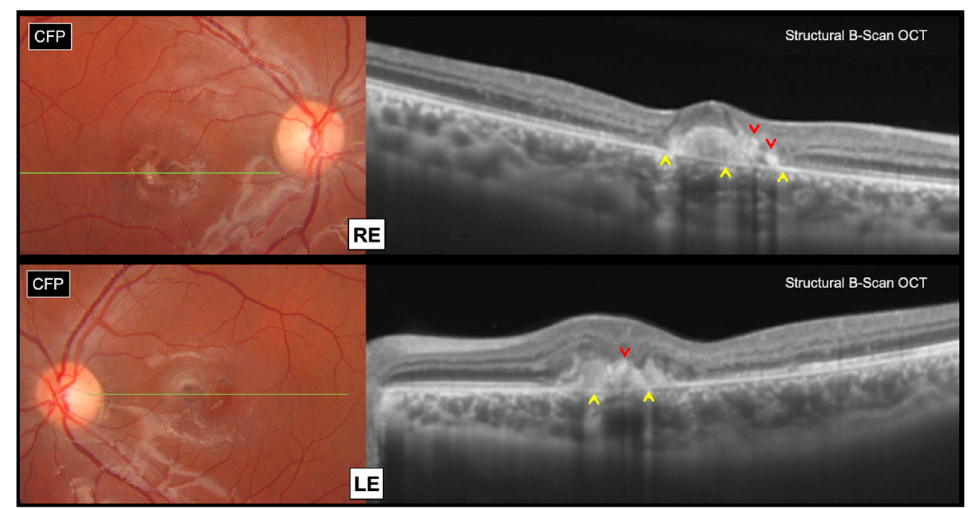
Figure 2. Swept source structural B-Scan OCT of macular lesions in both eyes (green lines on CFP corresponding to macular OCT scan levels). Bilateral subretinal hyperreflective lesions, without any subretinal fluid accumulation. Focal areas of outer retinal atrophy with choroidal hyper-transmis- sion (yellow arrowheads). Intraretinal pigment migration with back-shadowing (red arrowheads). Early phases fluorescein angiography (FA) (Heidelberg, HRA2, Heidelberg, Ger- many) showed window defects at the level of areas of atrophy, followed by dye filling of the central fibrotic lesions, in both eyes. Bilateral perifoveal capillary dye leakage was ob- served in late FA phases (Figure 3).